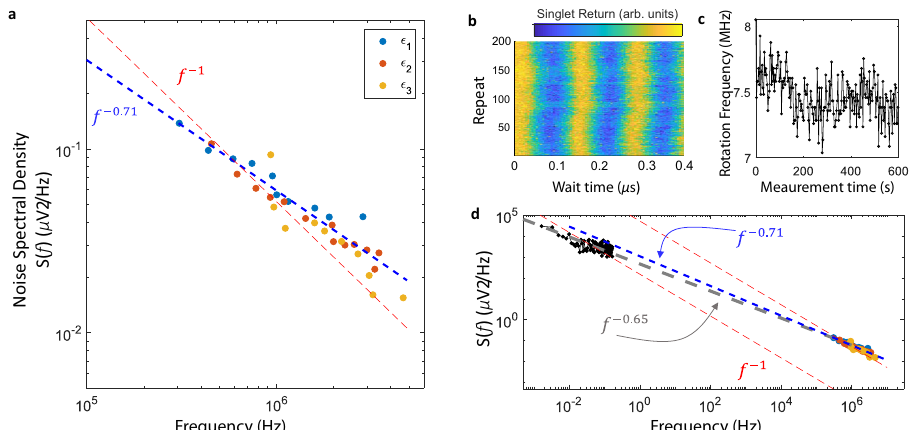
Fig. 5 Charge noise spectrum. a Noise spectral density for charge noise experienced by the qubit during exchange pulses for three QD-QD detuning values. The blue dashed line is a power law fi t to the data, S ( f ) ∝ f − α . The red dashed line is a fi t to a 1/ f noise spectrum as a guide to the eye. b Repeated experiment of singlet return probability versus wait time for an exchange pulse near detuning ϵ 3 over the course of 10 min. c Extracted qubit frequency for data in b as a function of experimental measurement time. d combined low- and high-frequency measurements of the noise spectral density. The blue dashed line is a power law fi t to the high frequency data and the gray dashed line is a power law fi t to the low frequency data extracted from c . The red dashed lines are fi ts of 1/ f spectra to the low- and high-frequency data sets, respectively, as guides to the